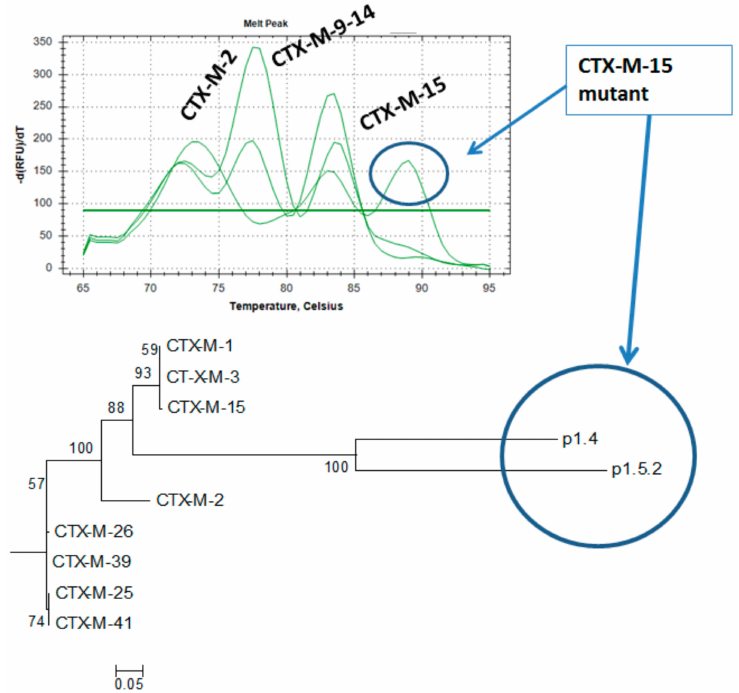
Figure 4. Detection of CTX-M-15 sequence mutant isolates p1.4 and p1.5.2 by postHRM sequencing of PCR amplicons for isolates, showing a new HRM peak at Tm of 89 ◦